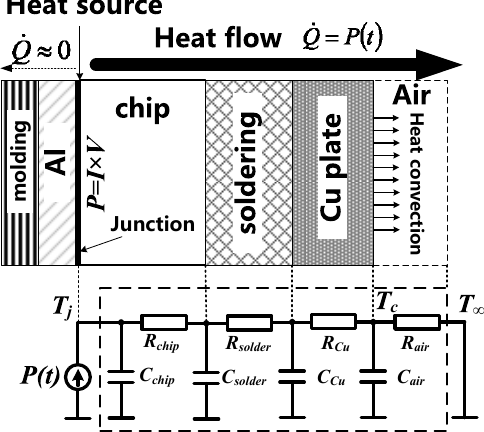
Figure 12. The compact thermal RC model of a packaged device. Each RC component stands for a layer of material. The power source stands for the heating power at the junction.